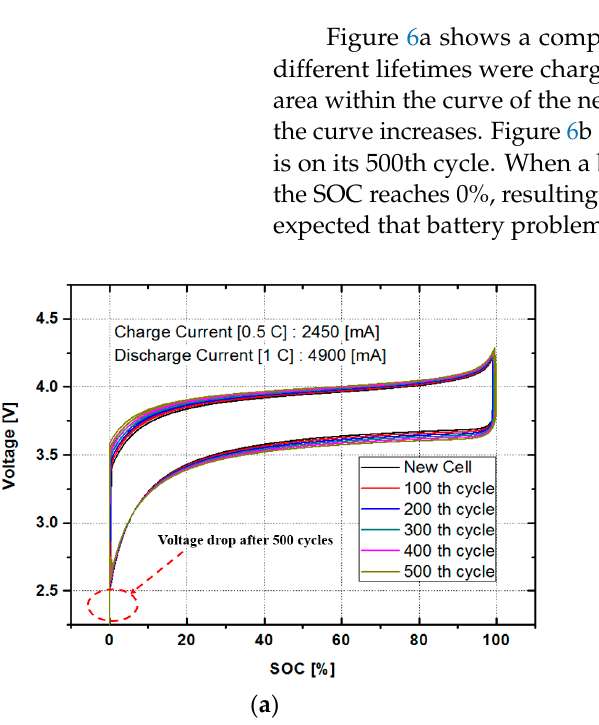
Figure 6. The voltage curve for SOC with different aging conditions (cycle number) using the same charge/discharge current: ( a ) voltage against SOC when using 0.5 constant current (CC), 1 discharge current (CD) for different aging conditions (0–500th cycle) and ( b ) voltage against SOC when using 0.5 CC, 1 CD for a new battery and a battery on its 500th cycle.